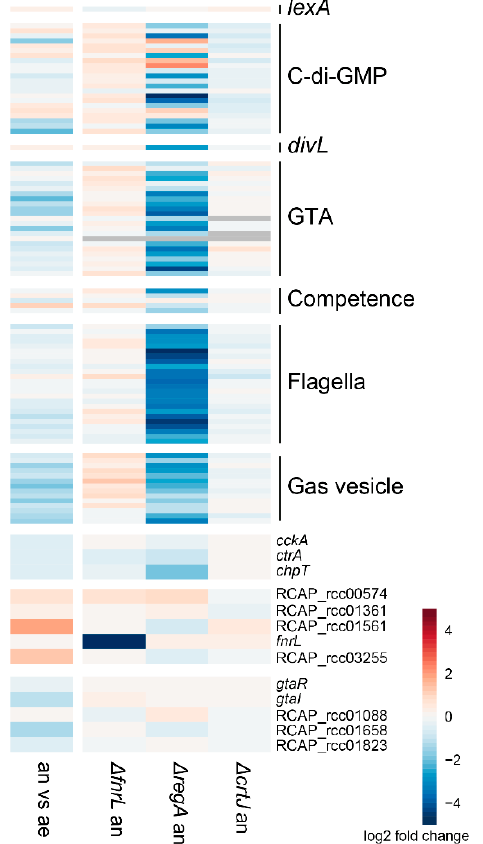
Figure 5. Effects of growth conditions and three regulator knockouts on the transcript levels of eight categorized groups of genes in Rhodobacter capsulatus . The microarray-based transcriptomic data for aerobic versus anaerobic growth in the wild type and for three mutants, fnrL , regA , and crtJ , compared to the wild type are shown.